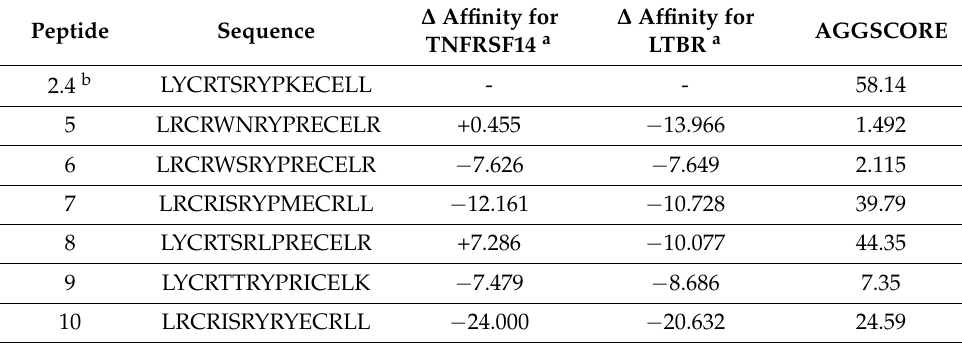
Table 3. Peptides selected from in silico optimisation for in vitro evaluation.